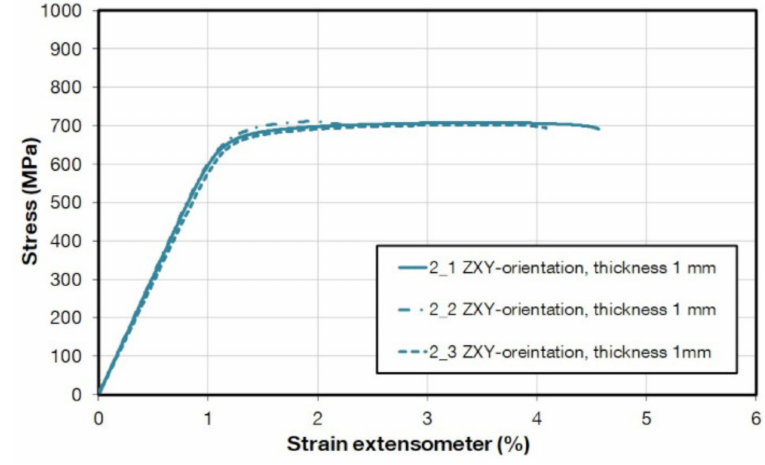
Figure 5. Engineering stress-strain curves of the as-deposited EBM-processed sample set with thickness of 1